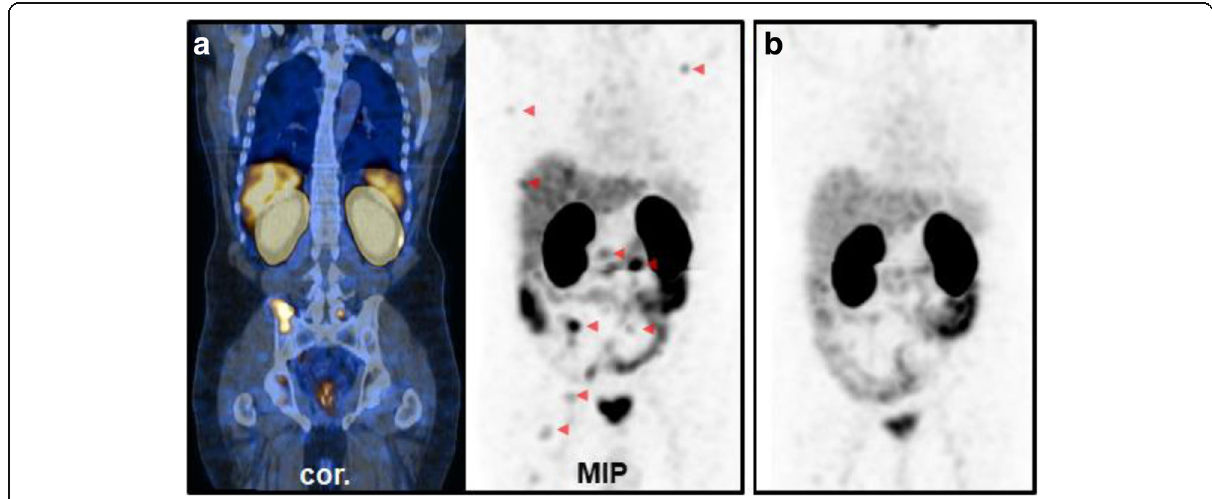
Fig. 7 [ 99m Tc]Tc-PSMA-I&S-SPECT/CT of a 59-year-old patient with radical prostatovesiculectomy and salvage radiotherapy. According to morphological imaging 2 years later osseous metastases were suspected. a At baseline, multiple osseous and lymph node metastases (partly marked with red arrows) were detected with mostly mild PSMA expression (PSA 4.75 ng/ml). b Follow-up scan 4 months later under antihormonal therapy (PSA 0.01 ng/ml). [ 99m Tc]Tc-PSMA-I&S-SPECT/CT was